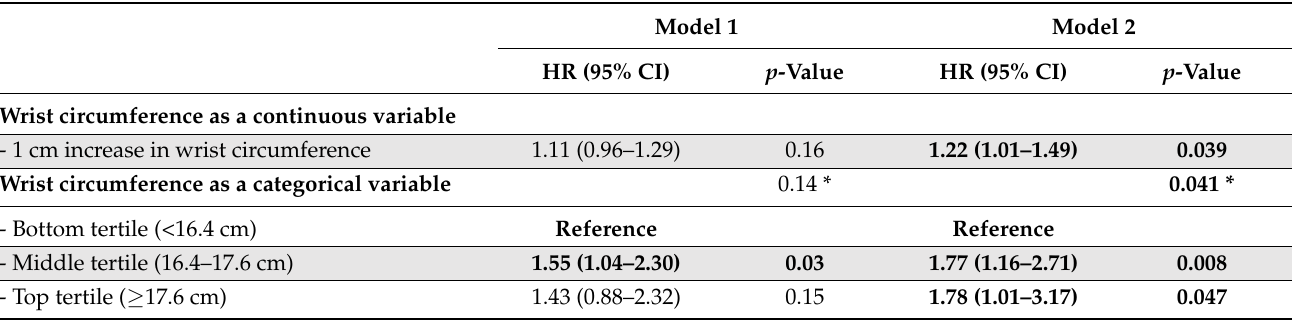
Table 5. Multivariable hazard ratios (HR) and 95% confidence intervals (CI) of incidence of major osteoporotic fracture: Tehran Lipid and Glucose Study,